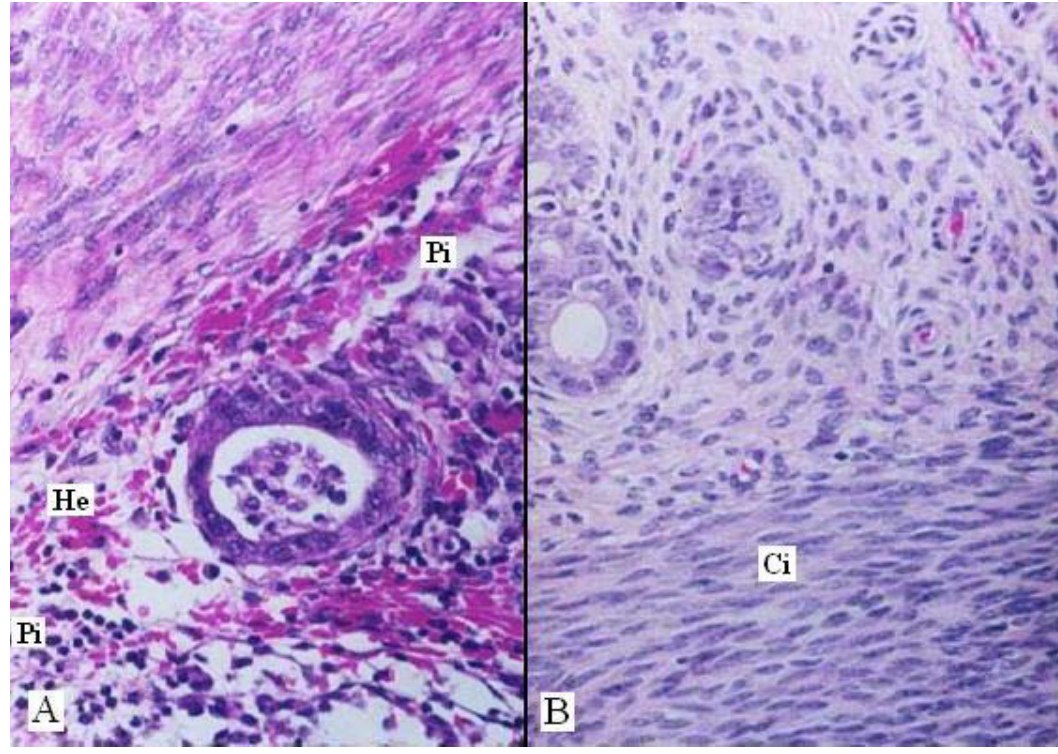
Figure 3. Microscopic aspect of the uterus 30 days after surgery – A = regenerative phase, concentration of inflammatory cells (Pi) and hemorrhage (He) in G . Staining HE reorganization in G 2